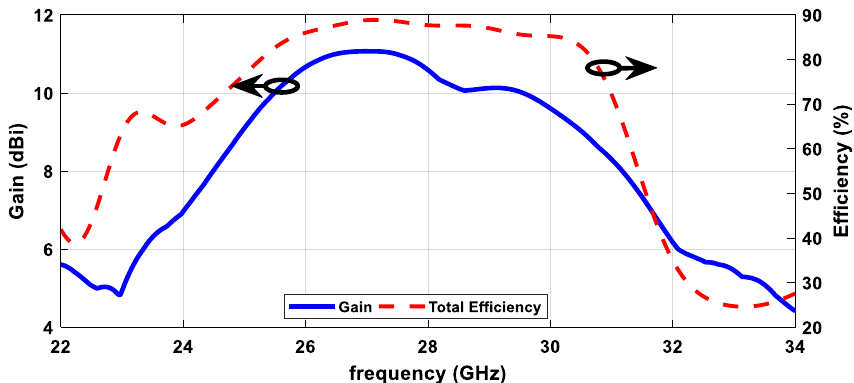
Figure 7. Variation of the Gain and Efficiency of the 5-element array over the frequency.